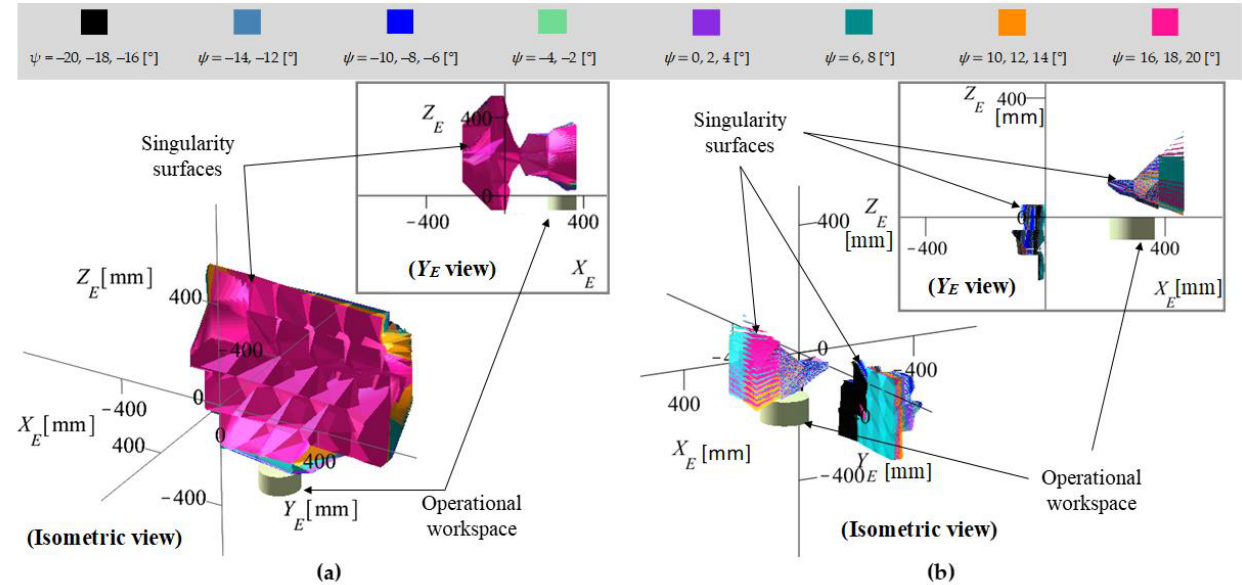
Figure 18. Output singularity surfaces: ( a ) without the inverse kinematic model constraints; ( b ) with the inverse kinematic model constraints. the inverse kinematic model